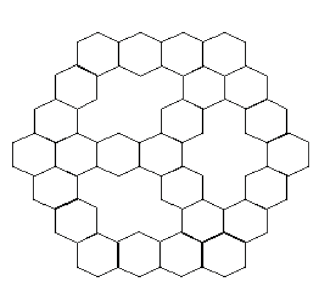
Figure 1. Zigzag-edge coronoid fused by Starphene ZCS ( 4, 4, 4 ) .